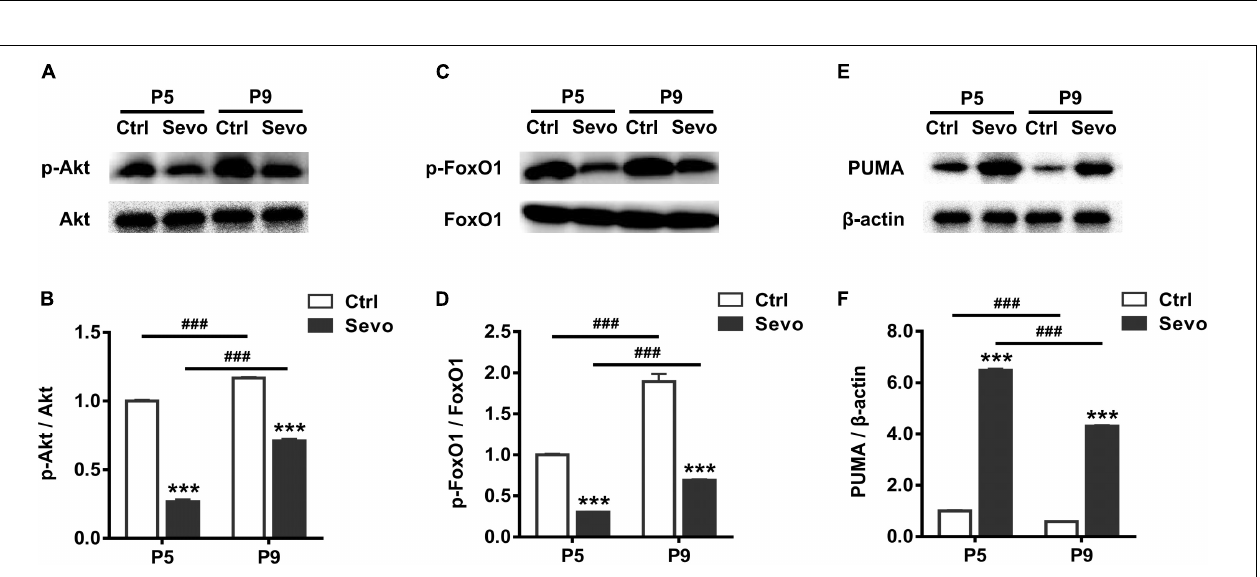
FIGURE 3 | Developmental changes in the Akt–FoxO1–PUMA pathway in regulating physiological and sevoflurane-induced apoptosis. Immunoblots and quantitation of phosphorylated Akt (A,B) , phosphorylated FoxO1 (C,D) , and PUMA (E,F) from the S1 region of control and sevoflurane-anesthetized mice at P5 and P9, respectively. * , sevoflurane group compared to control group of the same age; # , P5 compared to P9 in each treatment condition; *** , P < 0.001; ### , P < 0.001, using two-way analysis of variance followed by Tukey’s multiple comparisons test. Four mice were used per condition. Data are shown as the mean ± standard error of the